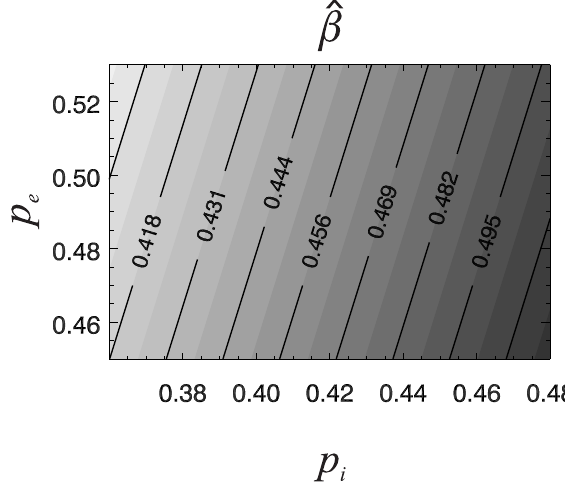
Fig. 9. Fitted plane to values for ˆ β